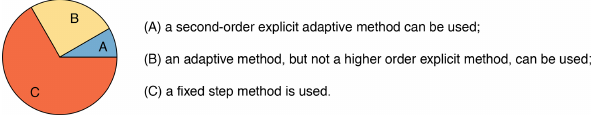
Figure 9. Grouping the reviewed modeling codes (12 in total) into three categories, based on available numerical techniques. Cate- gory C codes are the most